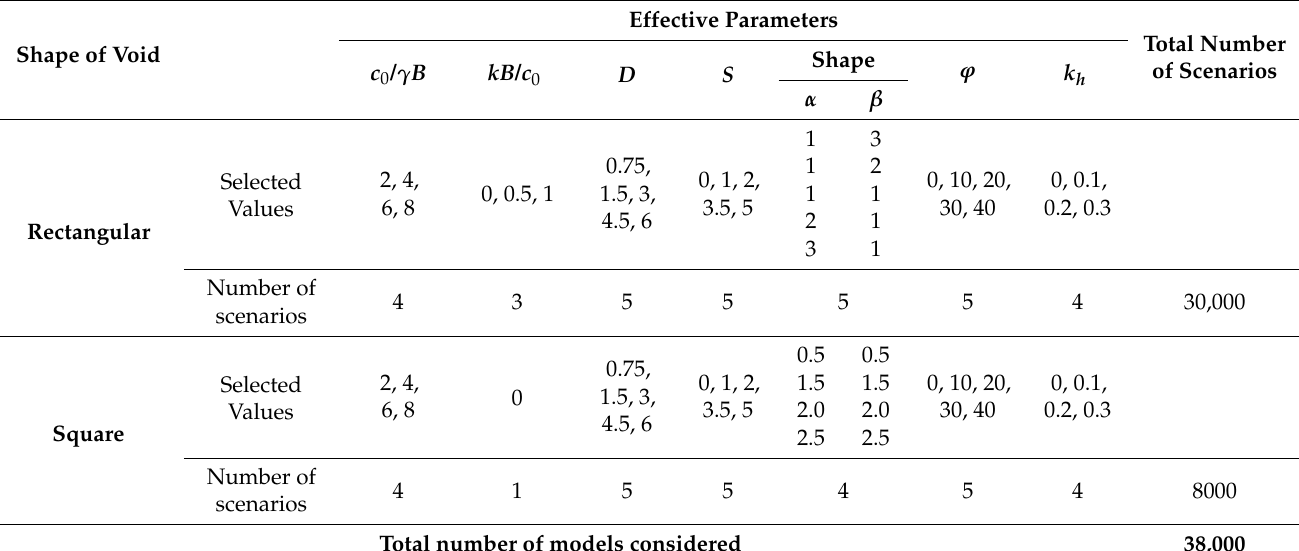
Table 4. Effective parameters and selected values for each model.